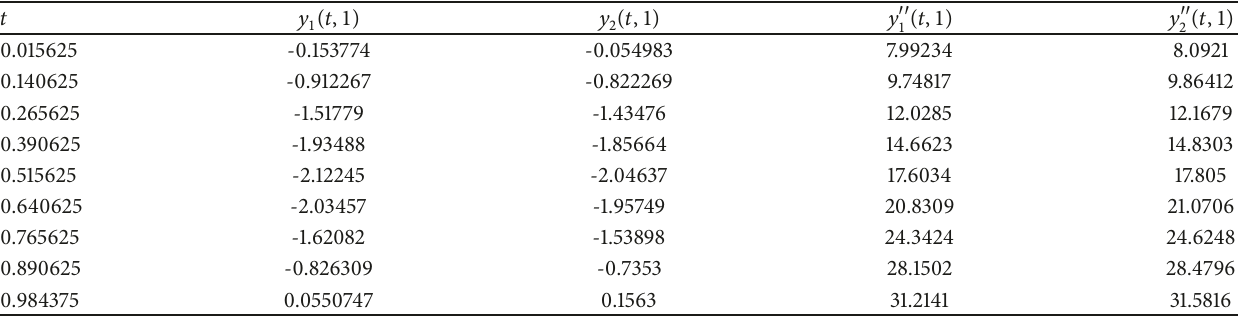
Table 2: In case of 𝑟 = 0.5 for Example